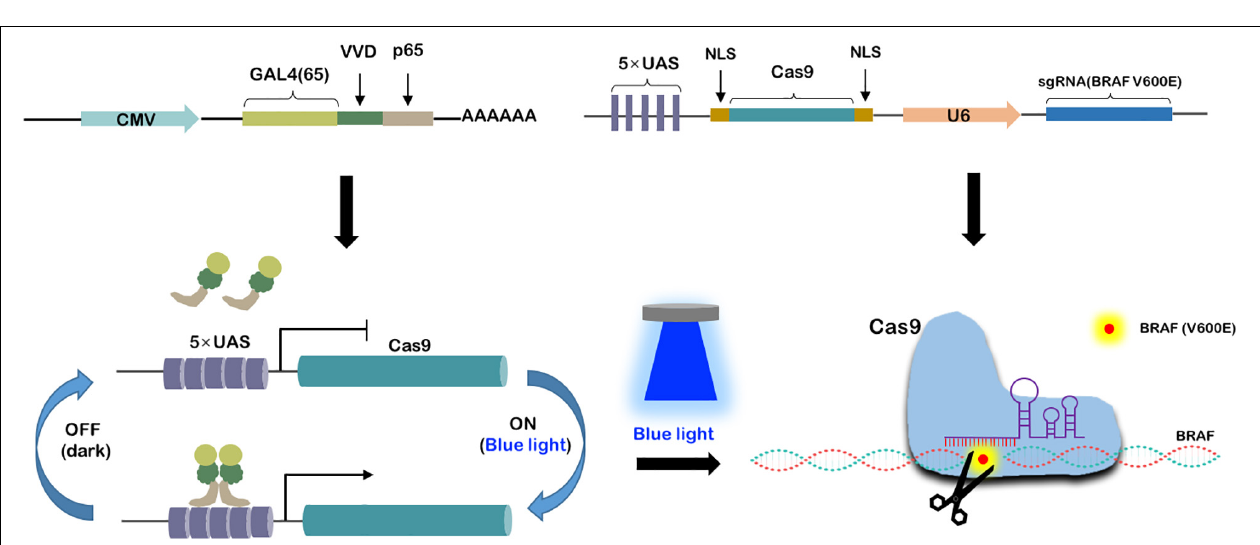
FIGURE 2 | Construction of blue light-induced BRAF V600E cleavage system. Synthesis of a blue light-induced BRAF V600E cleavage system based on two plasmids. One is CMV promoted GAL4(65), VVD and p65 fusion protein. The other is 5 × UAS promoted Cas9 and U6 promoted sgRNA. Under blue light condition, the fusion proteins get dimerized and activated the 5 × UAS promoter, leading to gRNA-Cas9 expression and BRAF V600E specific editing.